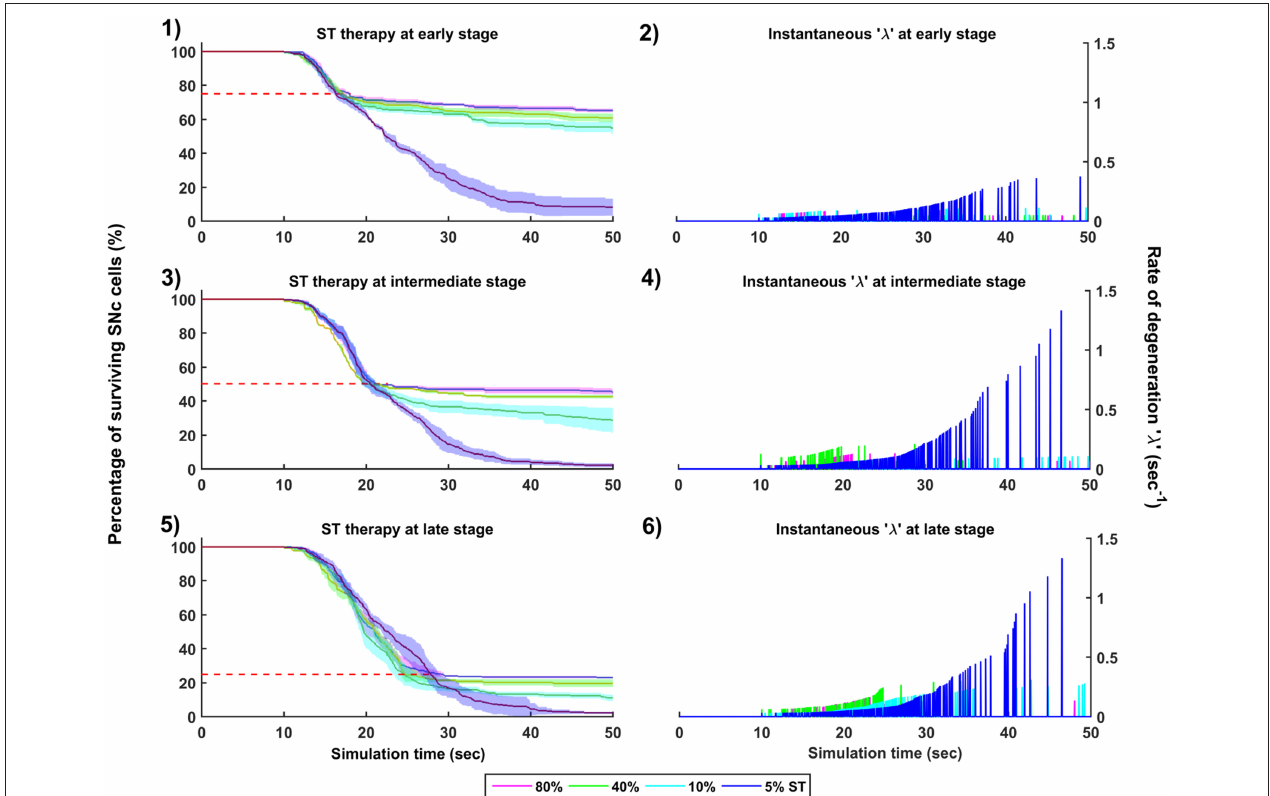
FIGURE 10 | Simulation plots for SuthalamoTomy (ST) therapy. Progression of SNc cell loss for 80, 40, 10, and 5% ST at early (25%) (1) , intermediate (50%) (3) and late (75%) (5) stages of SNc cell loss. Instantaneous rate of degeneration ( λ ) for 80, 40, 10, and 5% GI at early (25%) (2) , intermediate (50%) (4) and late (75%) (6) stages of SNc cell loss. SNc, Substantia Nigra pars